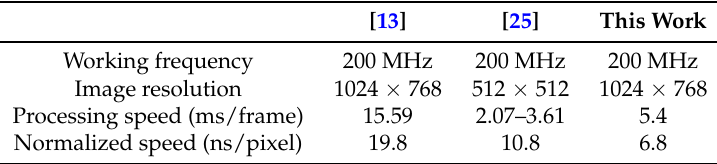
Table 1. Comparison results for straight-line-detection speeds.